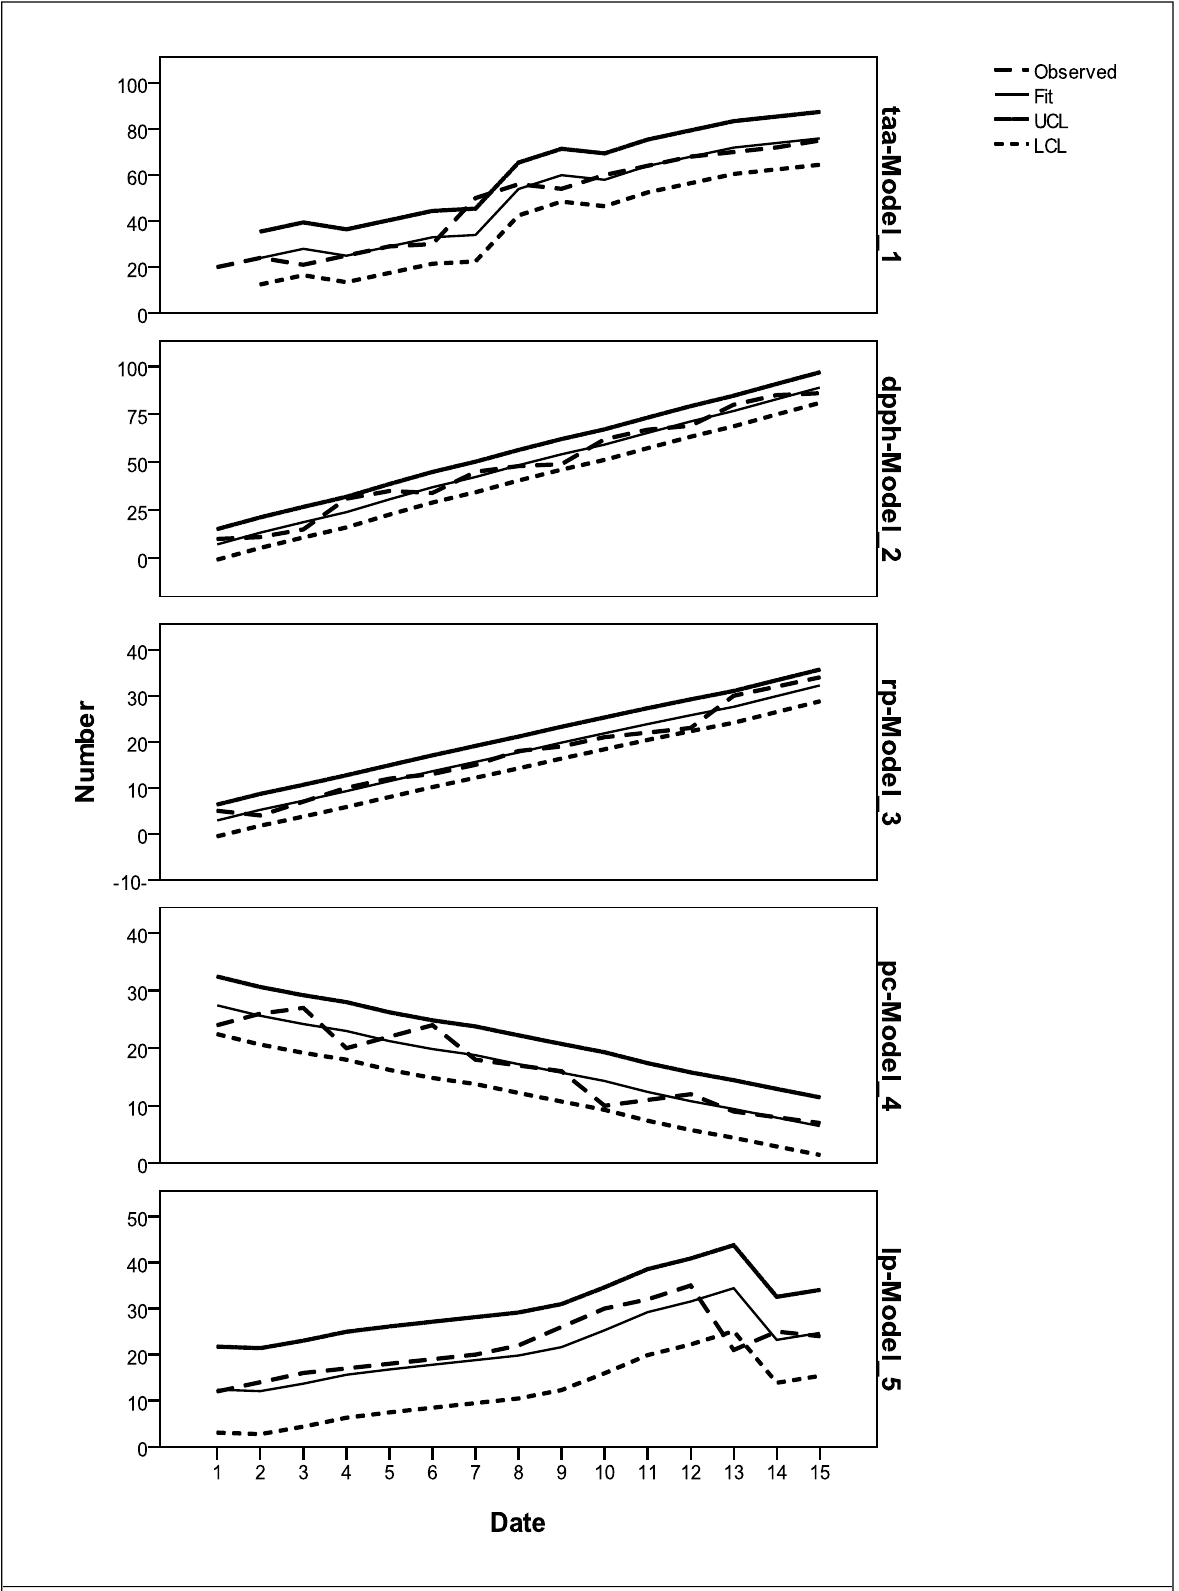
Figure 5: Time series of observed, fit, upper limit, lower limit, and forecast of time course post injection of vitamin B12 (0, 6, 12, 18, and 24 h) on the tested oxidative stress parameters total antioxidant capacity (tta), reducing power ability (rp), 2,2 diphenyl-1-picylhydrazyl (dpph), protein carbonyls amount (pc), and lipid peroxides levels (lp) of adult of Sitophilus